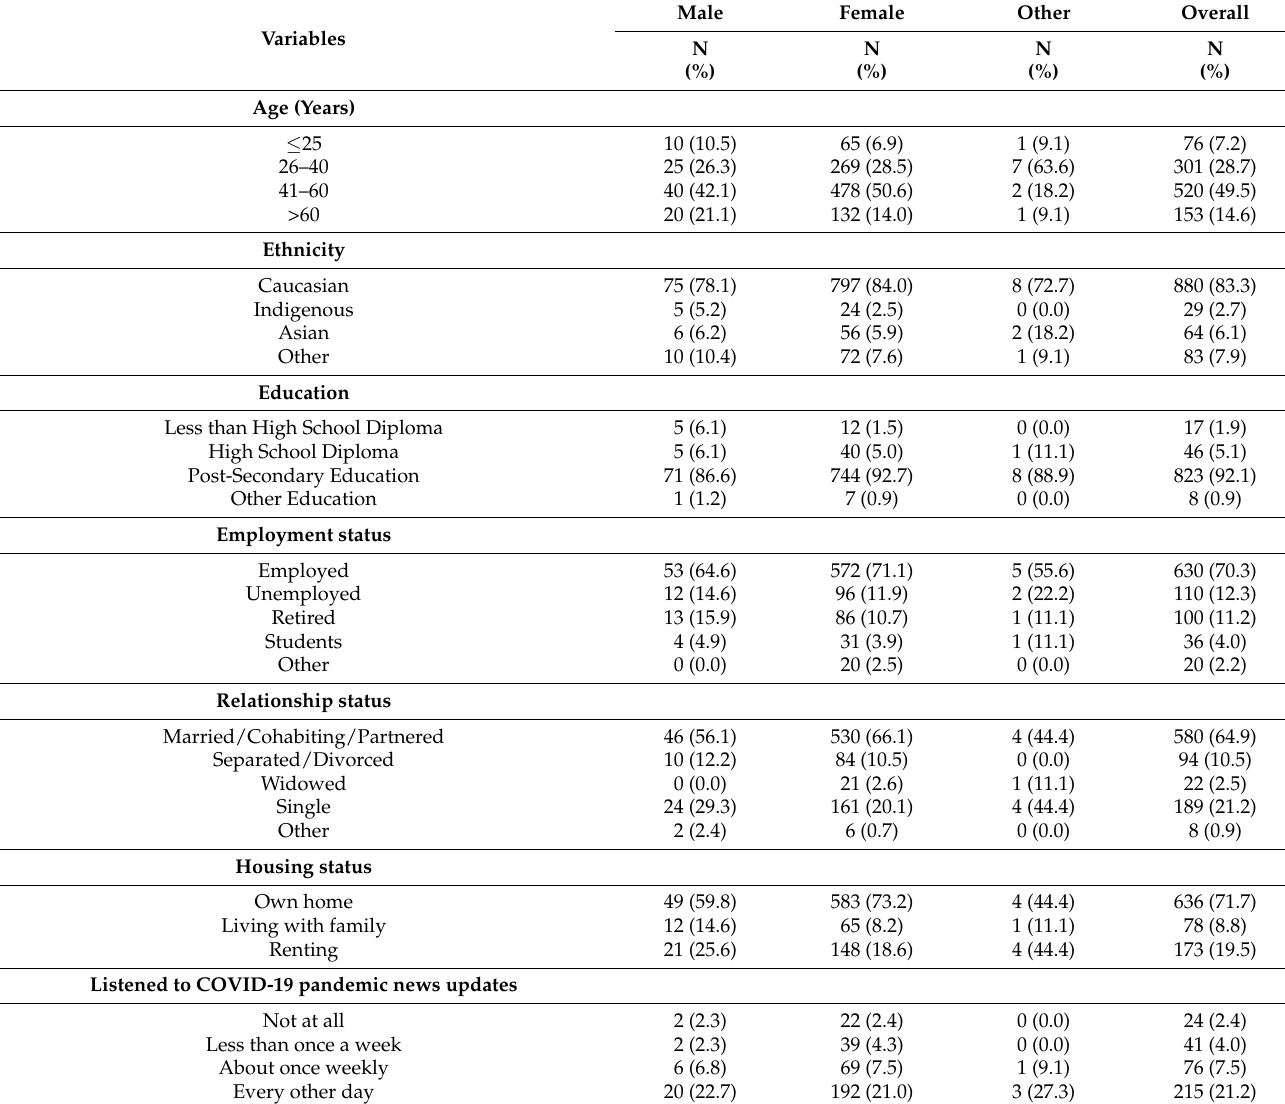
Table 1. Demographic characteristics of the study population and support for